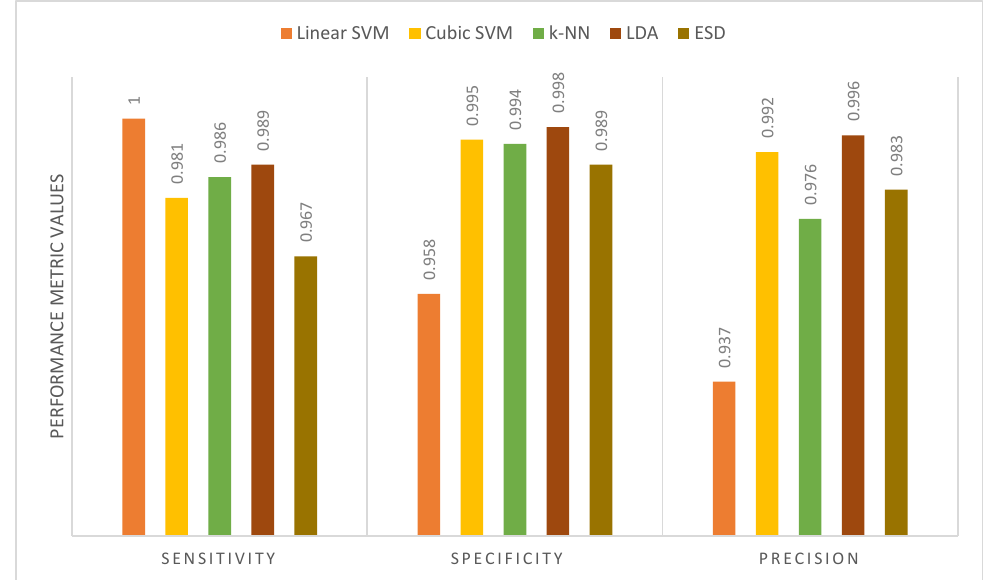
Figure 10. The performance metrics for the five classifiers used in MB-AI-His CADx after the fusion using DCT for the multi-class classification